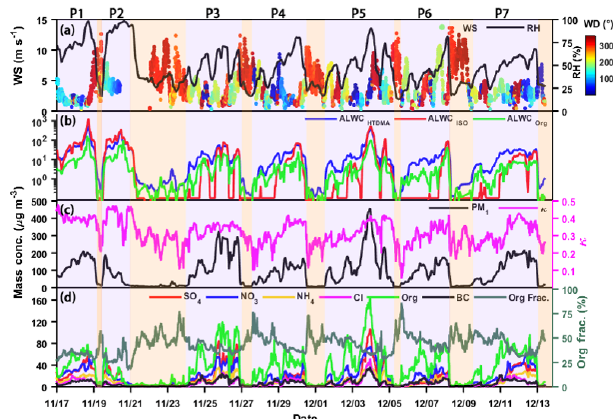
Figure 2. Time series of (a) wind speed (WS; left y axis), ambi- ent relative humidity (RH; right y axis) and wind direction (WD; colored dots); (b) ALWC HTDMA (in blue), ALWC ISO (in red) and ALWC Org (in green); (c) PM 1 mass concentration (left y axis) and hygroscopicity parameter ( κ ; right y axis) calculated using the ZSR model described by Eq. (7); and (d) mass concentrations of aerosol species in PM 1 (left y axis) and organic aerosol mass fraction (right y axis). Seven polluted episodes (segments of the time series with a purple background) are selected for examination. The date in this figure is in the mm/dd format.